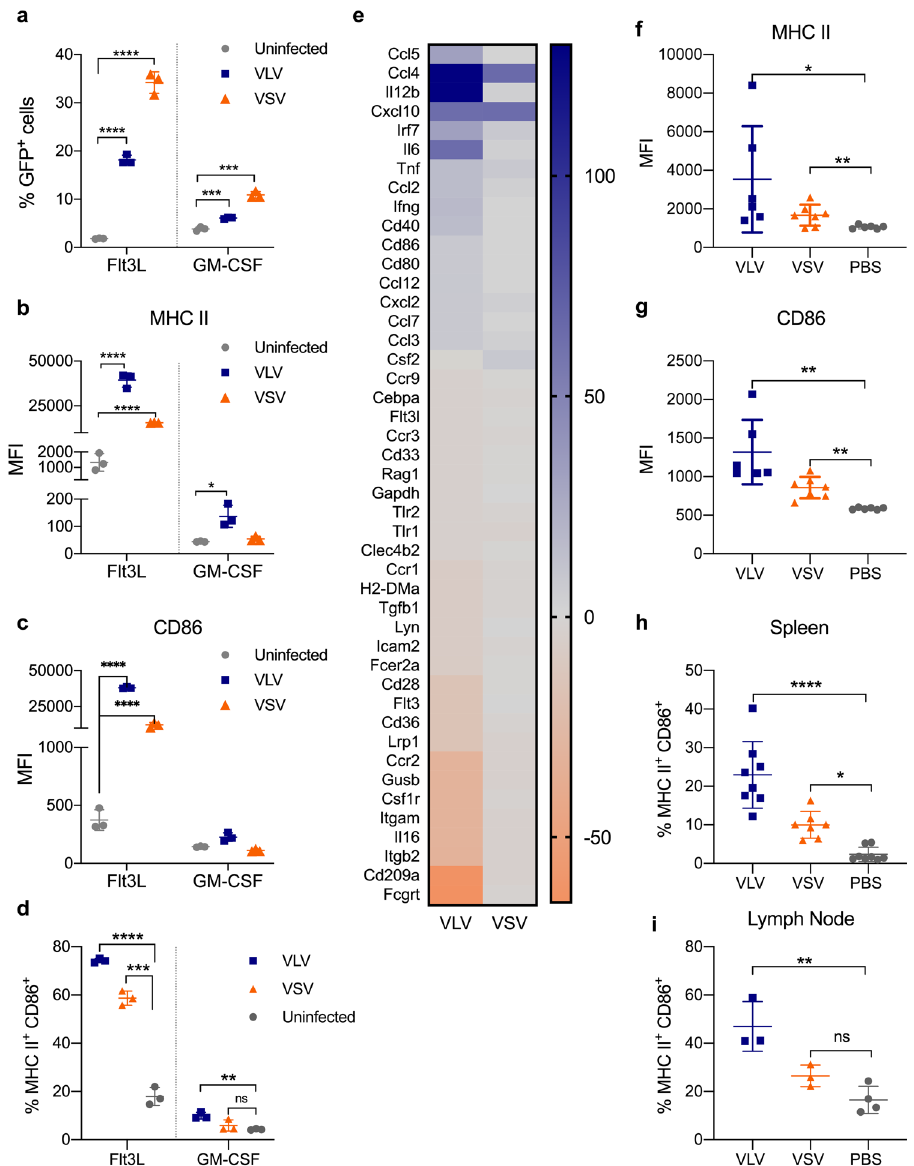
Fig. 1 Flt3L and GM-CSF BMDCs become differentially activated following infection with VLV or VSV. a – d Flt3L and GM-CSF DCs were infected with VLV or VSV expressing GFP for 18 h (MOI 10). After infection, cells were analyzed by fl ow cytometry for detection of GFP and activation markers. a Percentage of GFP + cells represents the percentage of infected cells. b MHC II and c CD86 DC activation markers after infection with VSV or VLV. d Percentage of MHC II + and CD86 + cells. e RT 2 PCR RNA analysis of genes associated with antigen presentation in Flt3L DCs 6 h post-infection relative to uninfected control. f – i C57BL/6 mice were infected intramuscularly with VLV or VSV, and 24 h later, spleen ( f – h ) and lymph nodes ( i ) were harvested to analyze cell activation. Cells were selected as CD3 − , CD19 − , CD11c + and then analyzed for activation marker expression. f MHC II and g CD86 DC activation markers in cells from the spleen after infection with VSV or VLV. h Percentage of MHCII + CD86 + cells in the spleen of immunized mice. i Percentage of MHCII + CD86 + cells in pooled lymph nodes from immunized mice. Data are expressed as mean ± standard deviation. * p < 0.05, *** p < 0.001, **** p < 0.0001 compared to uninfected cells or PBS treated mice by multiple t -test or one-way